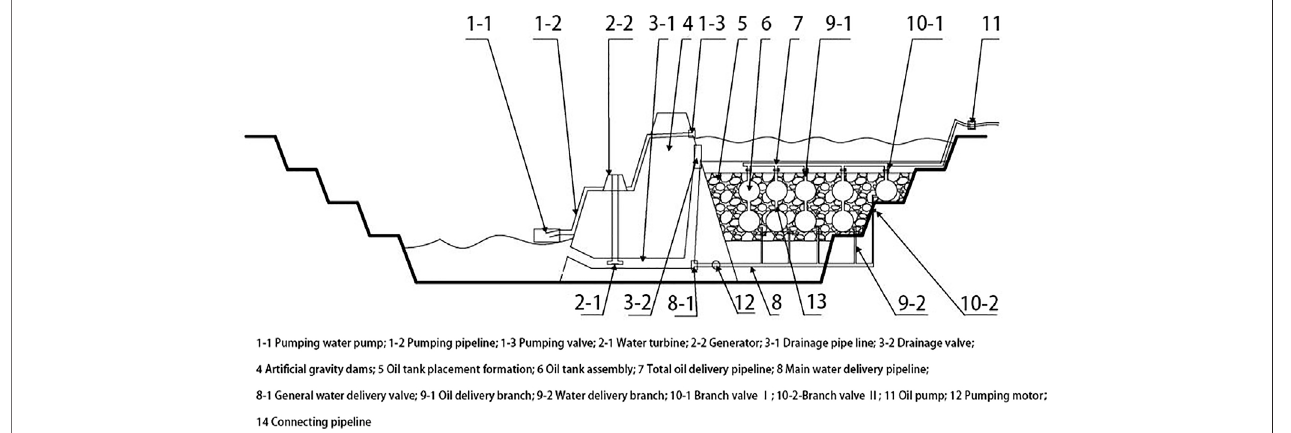
FIGURE 5 | Cross section of PHES with gravity dam reinforcement mode in West open-pit mine (redrawn from Cao).